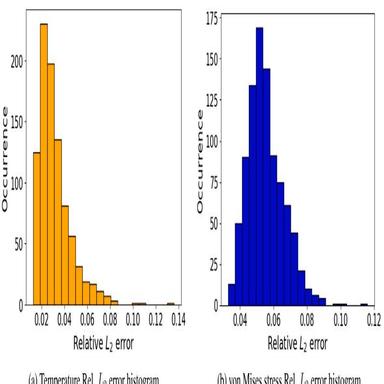
Relative 2 error histograms for test sampels.